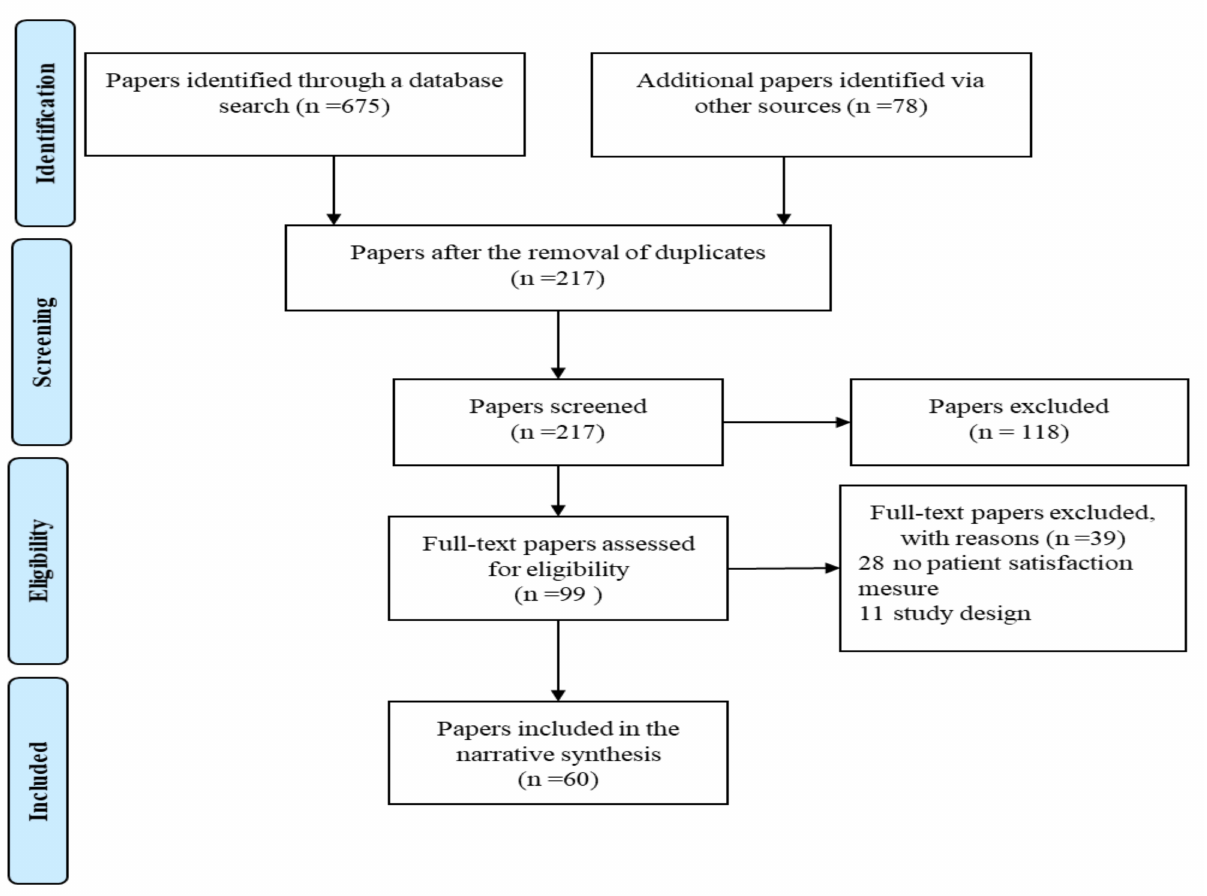
Figure 1. Search strategy and selection of